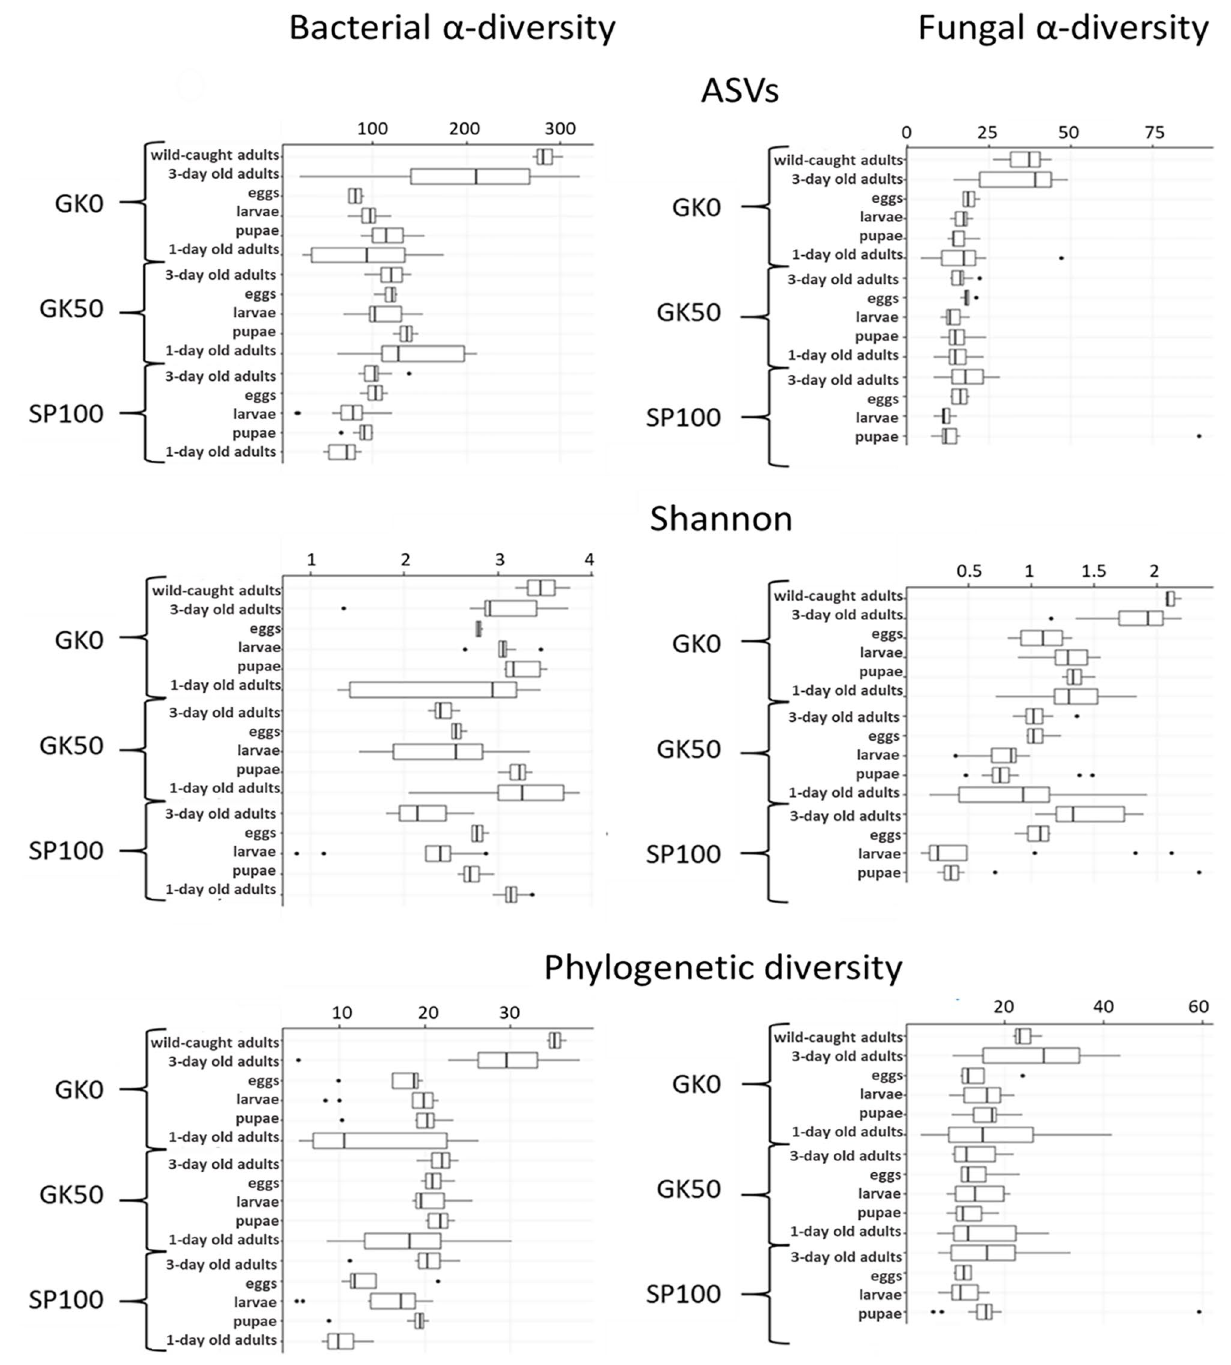
Figure 1. Bacterial and fungal alpha diversity of the microbial communities from developmental stages of three Musca domestica strains, estimated with three diversity metrics: the number of Amplicon Sequence Variants, Shannon index, and Faith’s Phylogenetic Diversity. The line in each boxplot represents the median of all values, with the upper limit of the box being the first and the lower limit of the box being the third quartile. Each boxplot represents all samples of one housefly strain (GK0, GK50, or SP100) per developmental stage (3 day old adults, eggs, larvae, pupae, 1 day old adults), i.e. three biological replicates for four generations. For the GK0 strain, one separate boxplot represents the wild-caught adults immediately after collection (adults from the farm). GK0: field population, the Netherlands; GK50: laboratory population originally collected in the Netherlands; SP100: laboratory population originally collected in